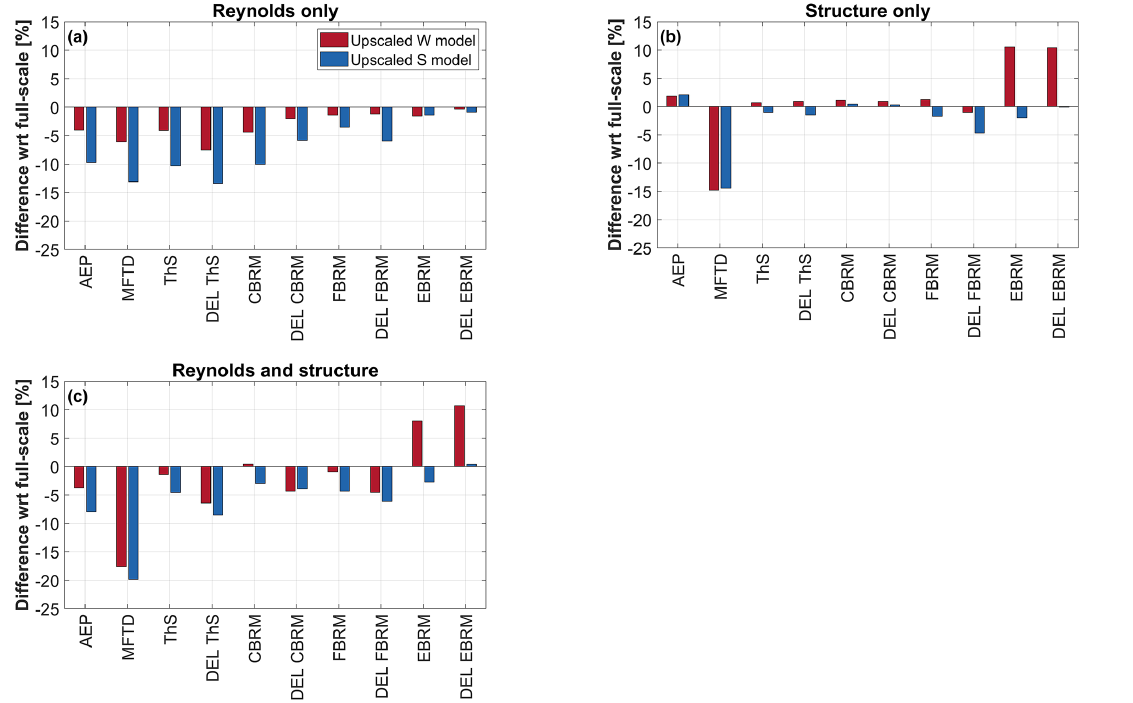
Figure 6. Changes with respect to full scale for several key indicators for the W and S models. (a) Effects exclusively due to Reynolds mismatch, (b) effects exclusively due to structural redesign, and (c) realistic solution considering both the effects of Reynolds mismatch and structural redesign.